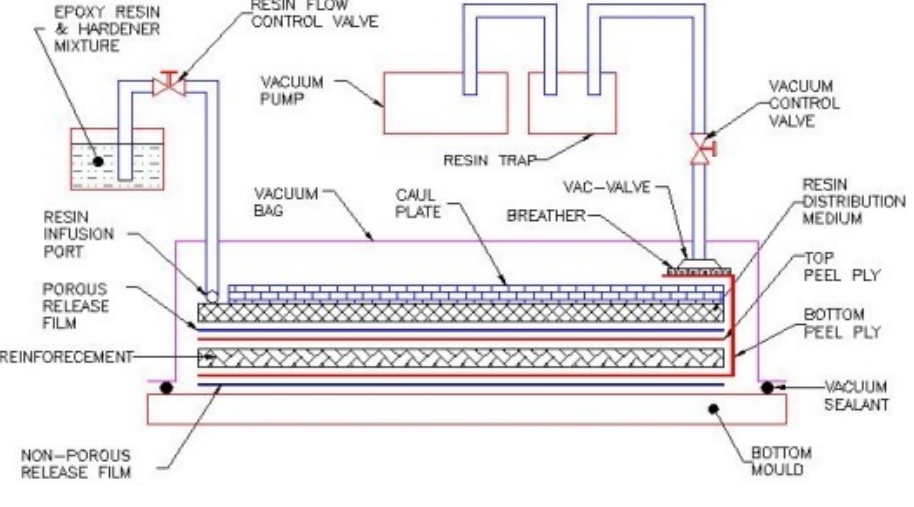
Figure 7. Resin infusion arrangements.